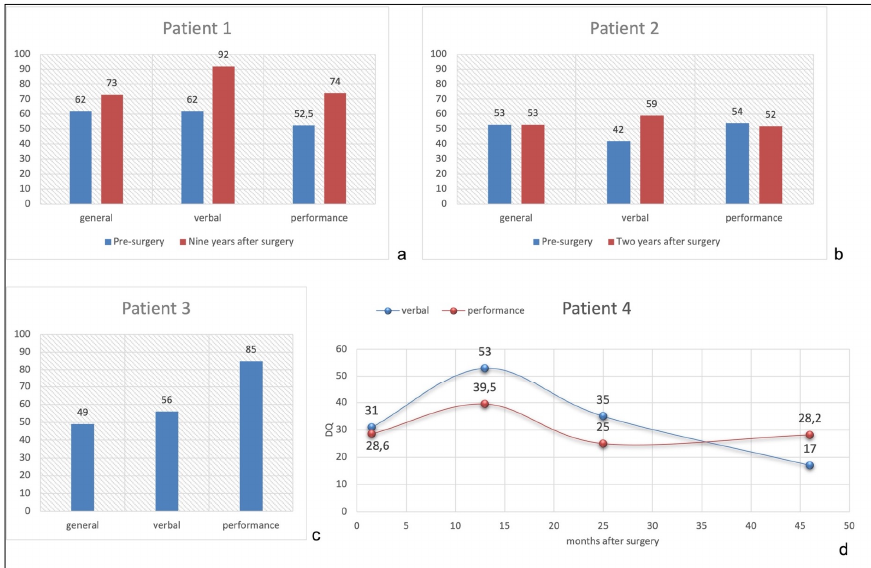
Figure 3. ( a ): Patient 1 pre- and post-surgical quotients. ( b ): Patient 2 pre- and post-surgical quotients. ( c ): Patient 3 post-surgical quotients. ( d ): Patient 4 post-surgical verbal and performance quotients performed at 3.5, 15, 27, and 48 months after surgery.